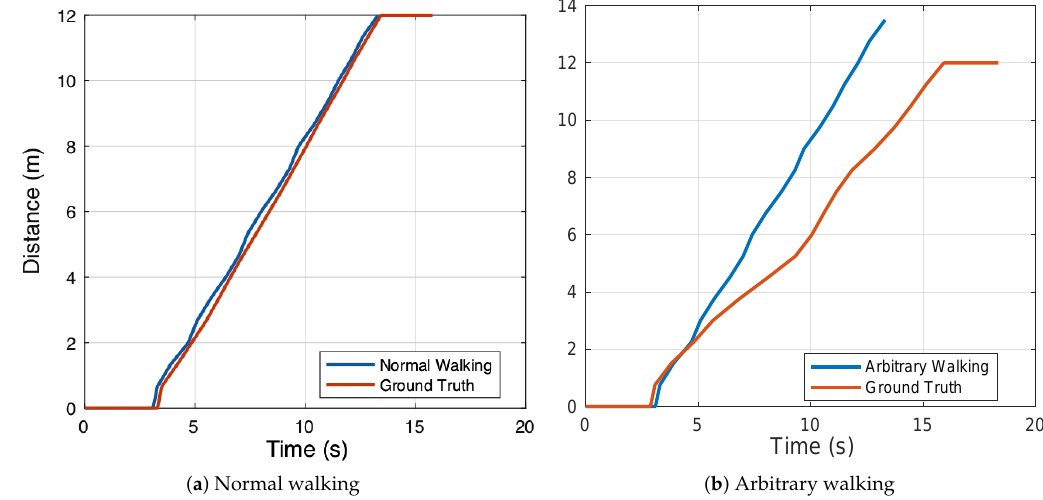
Figure 2. Accumulative distance bias caused by pedestrian dead-reckoning (PDR) with different pedestrian walking